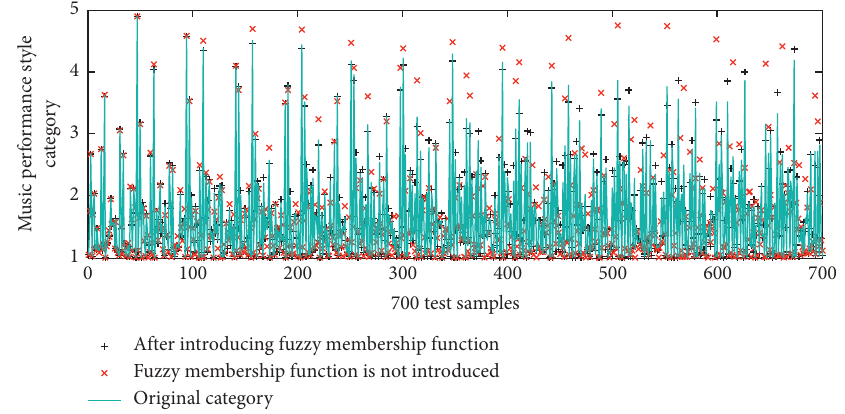
Figure 5: Classification results of 700 test samples before and after citing the fuzzy membership function.